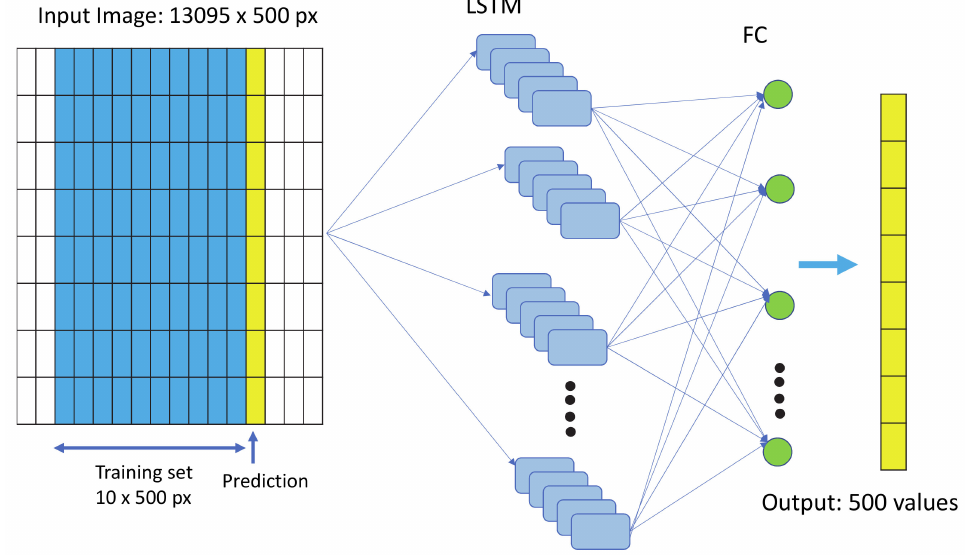
Figure 5. Overview of the architecture of the stack of neural